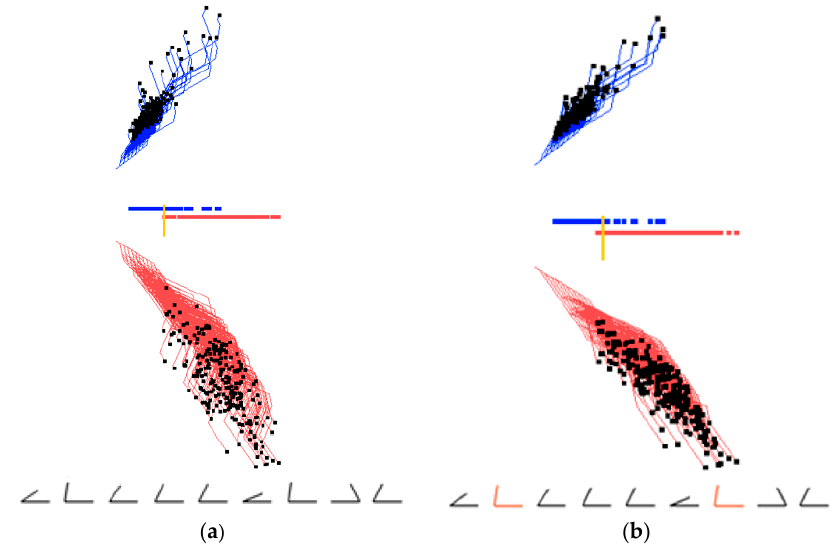
Figure 5. Interactive dimension reduction, angles for each dimension are shown on the bottom. ( a ) Initial visualization of two classes optimized by GLC-AL algorithm ; ( b ) Visualization of two classes after 2nd and 7th dimensions (red) with low contribution (angle about 90°) have been removed .